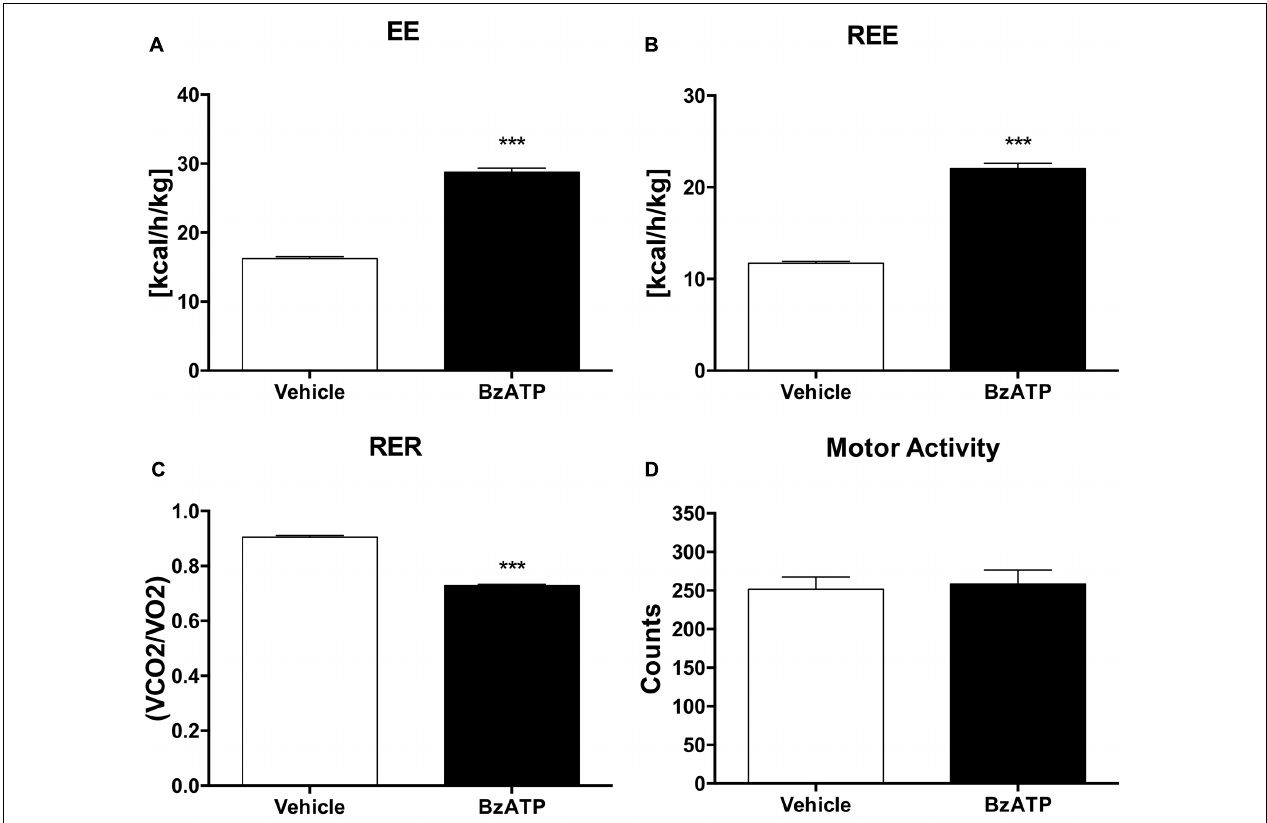
FIGURE 2 | BzATP increases energy expenditure and reduces respiratory exchange ratio. (A) Mean ( ± SEM) of 48 h EE expressed as Kcal emitted by whole body per hour, per Kg of body weight (Kcal/h/kg). (B) Mean of 48 h resting EE (REE) expressed as whole body EE in lack of motor activity (Kcal/h/Kg). (C) Mean ( ± SEM) of 48 h respiratory exchange ratio (RER), expressed as ratio of produced CO2 volume to used O2 volume (VCO 2 /O 2 ). (D) Mean ( ± SEM) of 48 h locomotor activity (counts). ( ∗∗∗ P < 0,0001 vs.